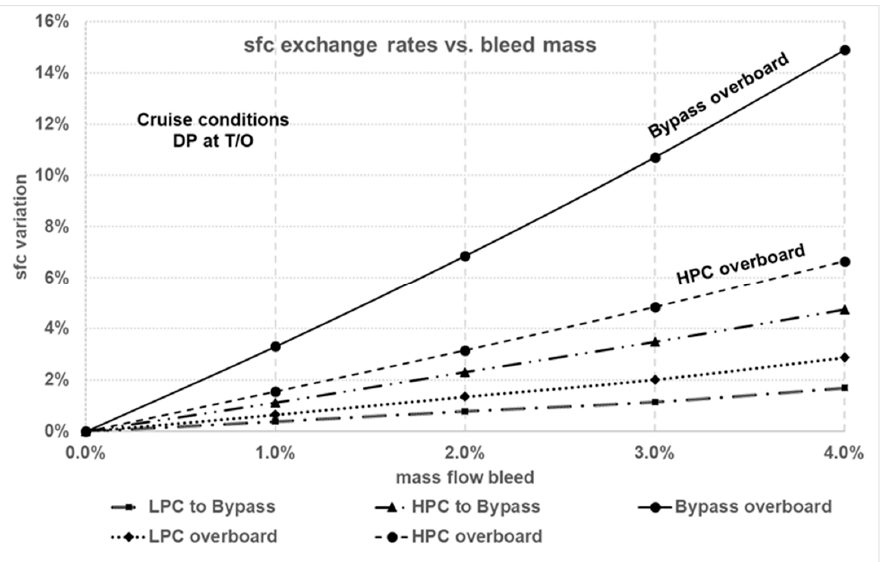
Figure 16. SFC exchange rates vs. bleed mass.